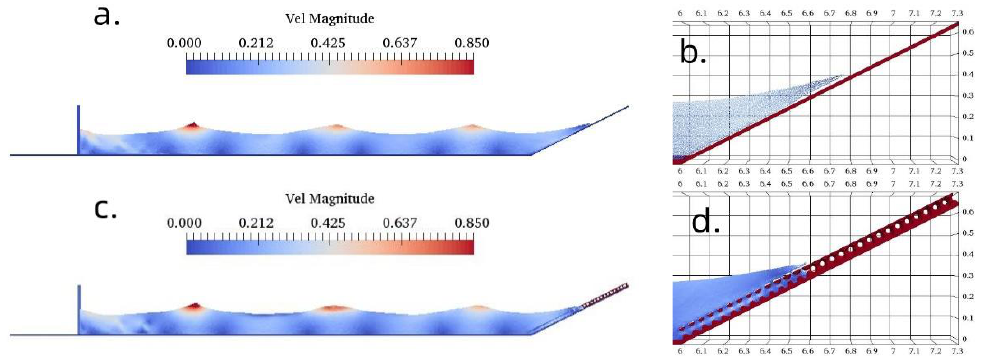
Figure 9. The same as Figure 7, but for wave climbing to the top along the breakwater at t = 5.75 s.